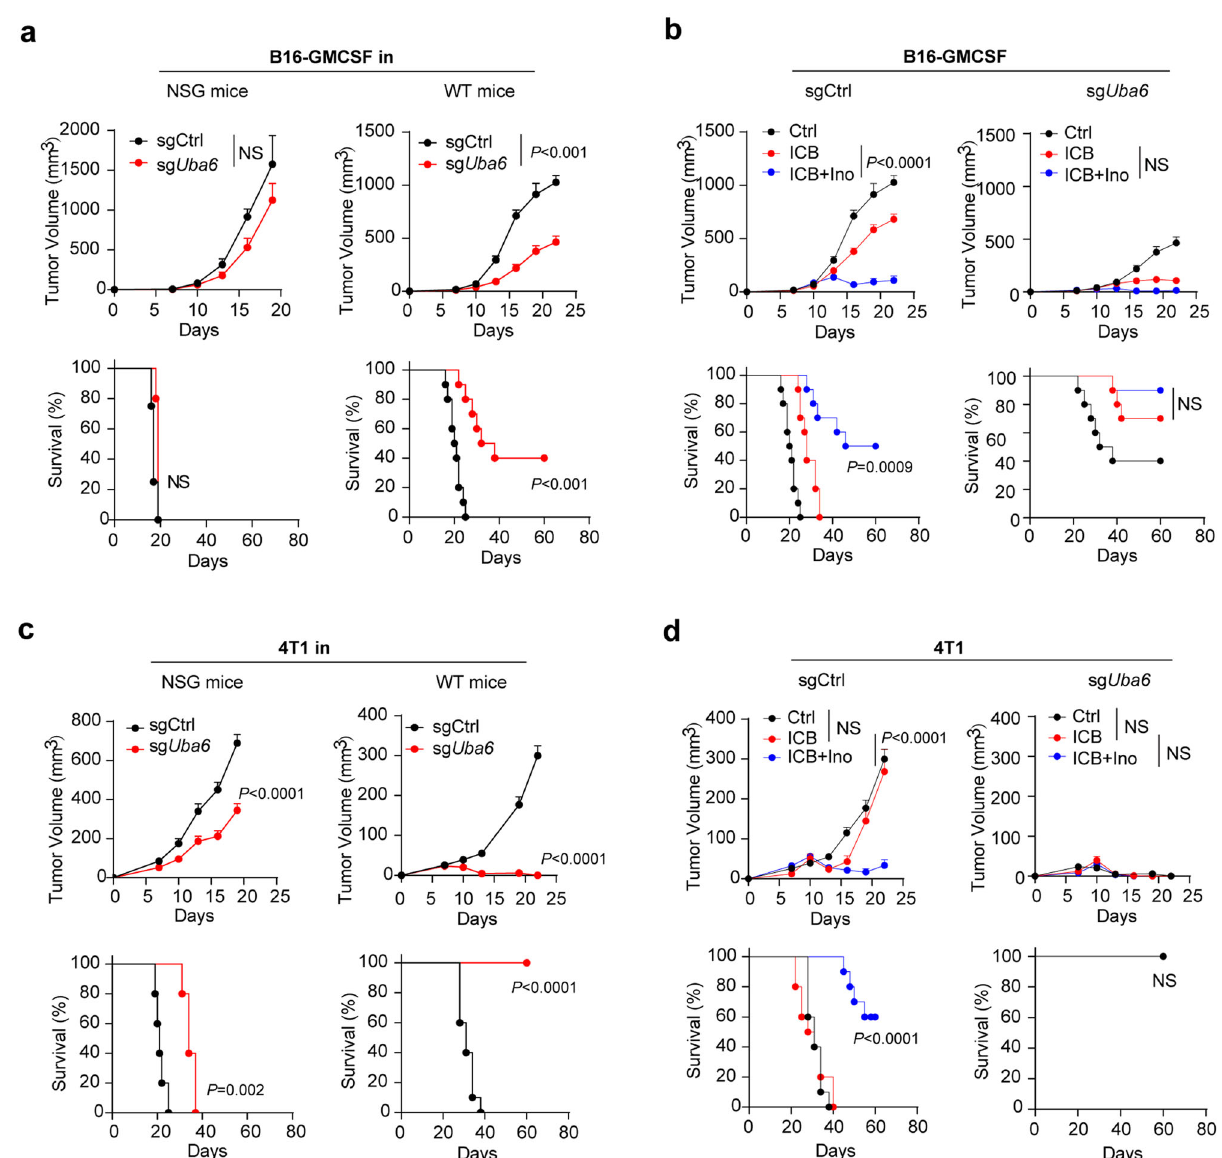
Fig.5|UBA6deletionsubstitutestheeffectofinosineonantitumourimmunity in vivo. a Tumour volume and survival analysis of sgCtrl and sg Uba6 B16-GMCSF tumours in NSG, wild-type (WT) mice ( n =8). b Tumour volume and survival ana- lysis of sgCtrl and sg Uba6 B16-GMCSF tumours in WT mice with Ctrl, ICB, or ICB+Ino treatment ( n =8). c Tumour volume and survival analysis of sgCtrl and sg Uba6 4T1tumour-bearing NSGmice (left)orwild-type(WT) mice(right)( n =10).